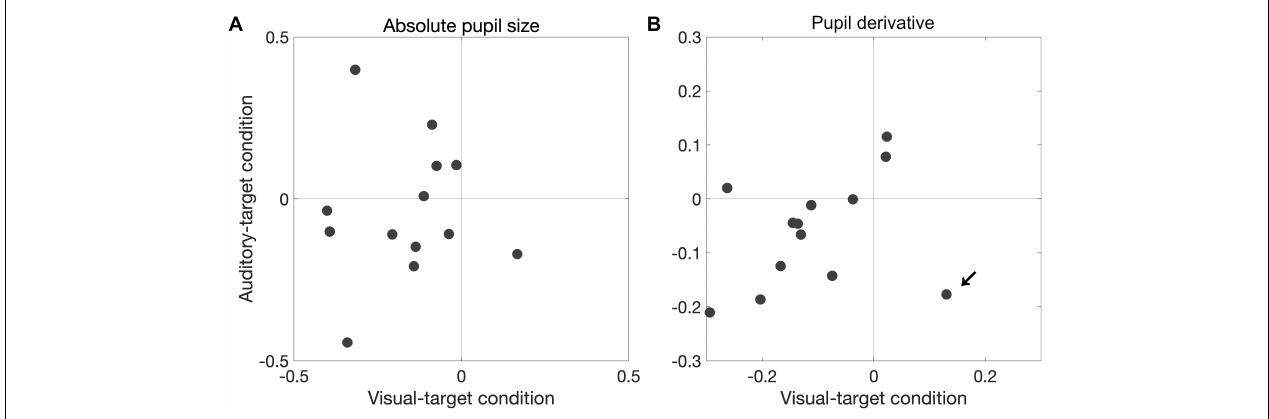
FIGURE 8 | Consistency in pupil-SRT correlation between the visual- and auditory-target conditions for absolute pupil size (A) and for pupil derivative (B) . The correlations (of the correlation coefficients for the visual- and auditory-target conditions) were not significant for either absolute pupil size or the pupil derivative. However, when an apparent outlier participant (marked by the arrow; different from the one marked in Figure 7 ) was excluded, the correlation would became significant (Pearson’s r = 0.62, p = 0.037).